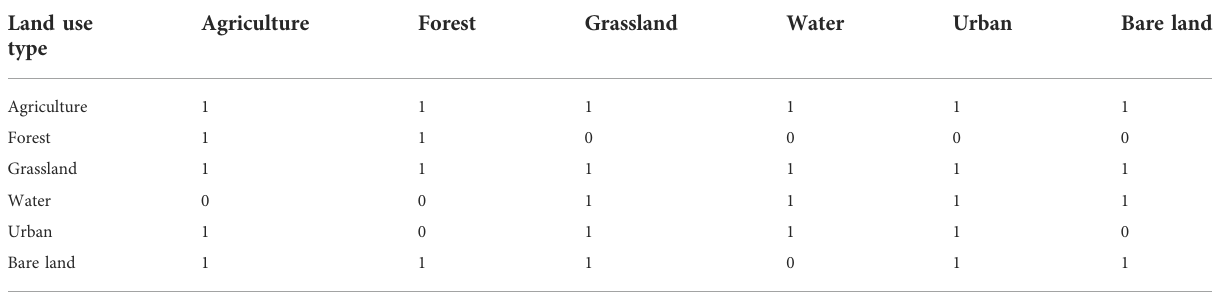
TABLE 2 Transfer matrix of land-use change under NDS.